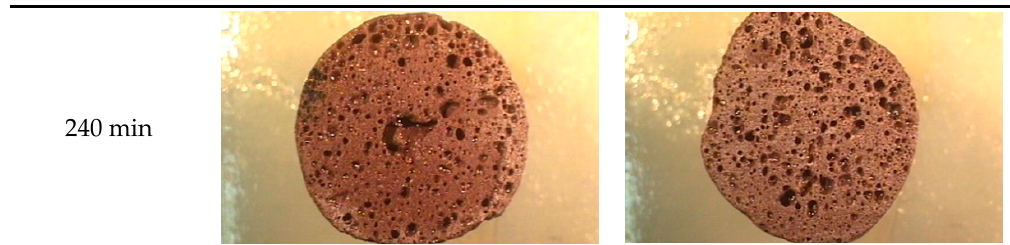
Figure 8. Cross-section of the aggregate according to the heating time.